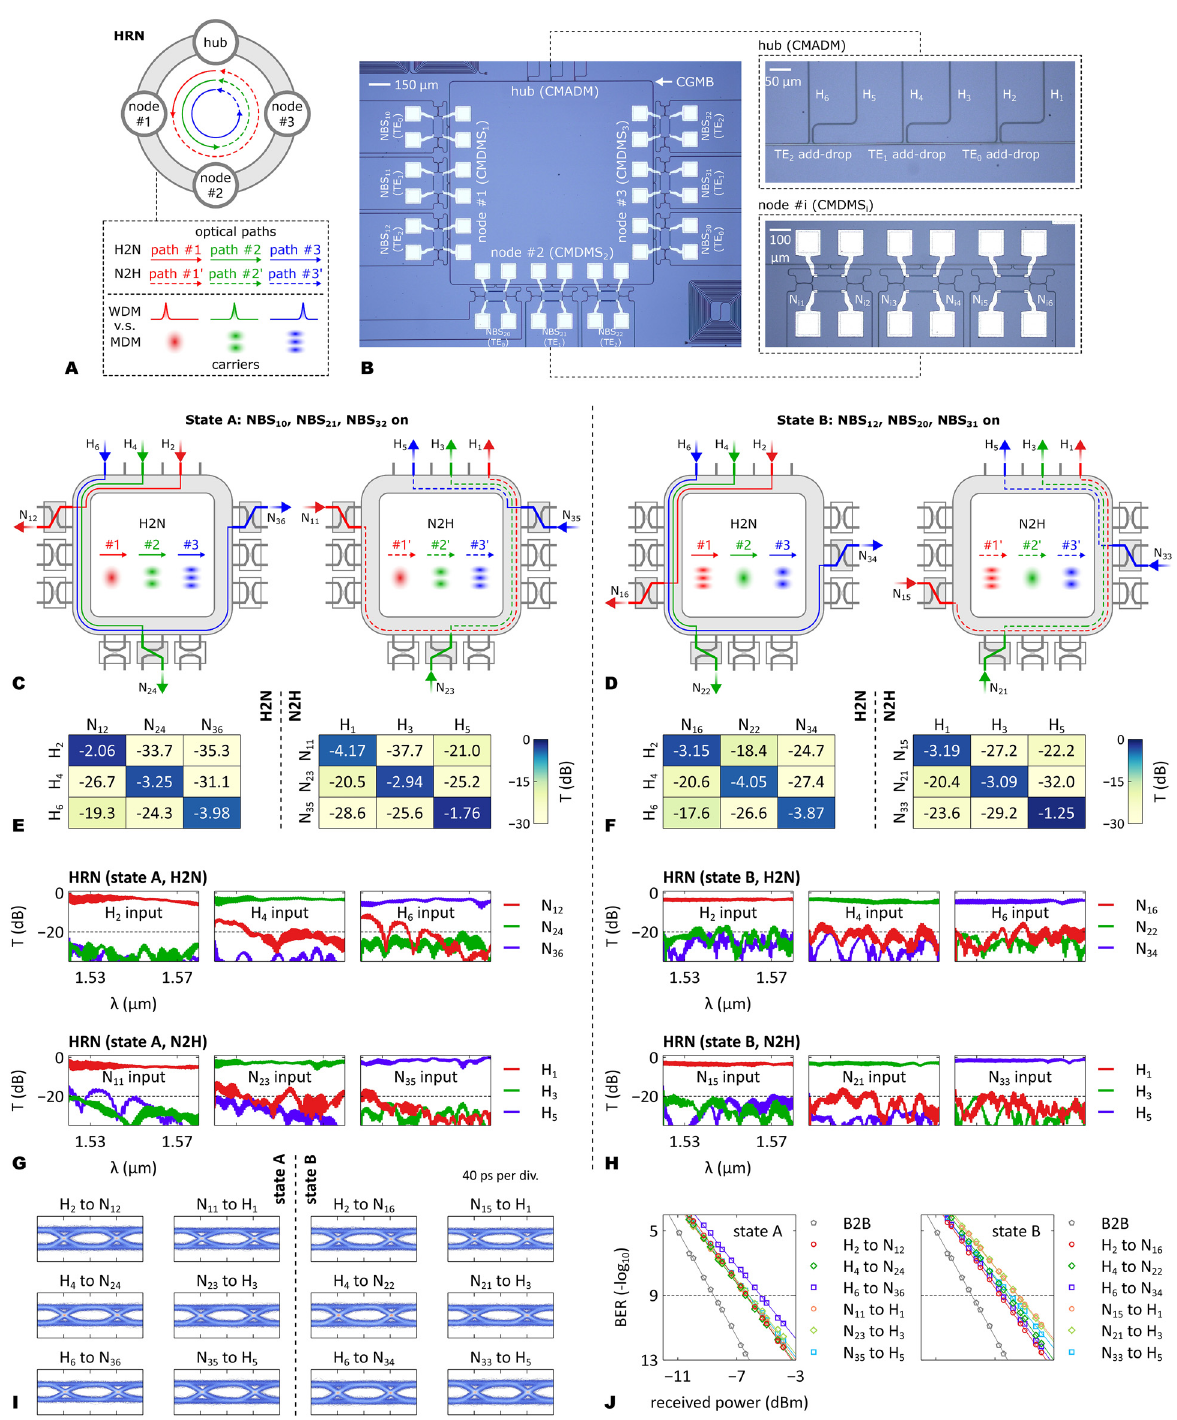
Figure 9: Design and results for the reconfigurable multi-mode hubbed-ring network (HRN). (A) The illustration of HRNs based on wavelength-division multiplexing (WDM) and mode-division multiplexing (MDM). (B) The optical microscope image of fabricated HRN. The dashed boxes show enlarged views of cascaded mode add-drop multiplexers (CMADM, upper panel) and cascaded mode-divisionmultiplexingswitches(CMDMS,lowerpanel).TheHRNconsistsofoneCMADMasacentralhubandthreeCMDMSs asaccessnodes #1 – 3.Theportandswitchidentifiersarealsolabeled.Theillustrationsofhub-to-nodes(H2N)andnodes-to-hub(N2H)linksforHRNat(C)stateAand (D) state B. The shaded boxes illustrate which normally-bar switches (NBS) are turned on. The measured transmittance matrices for the HRN at (E)stateAand(F)stateB( λ =1.55 μ m).ThemeasuredtransmittancespectrafortheHRNat(G)stateAand(H)stateB.Themeasured(I)eye-diagrams and(J)bit-errorrates(BER)with10 Gbpsdatalinksat λ =1.55 μ musingmulti-portmethod.CGMB,curvature-gradientmulti-modebend;B2B,back-